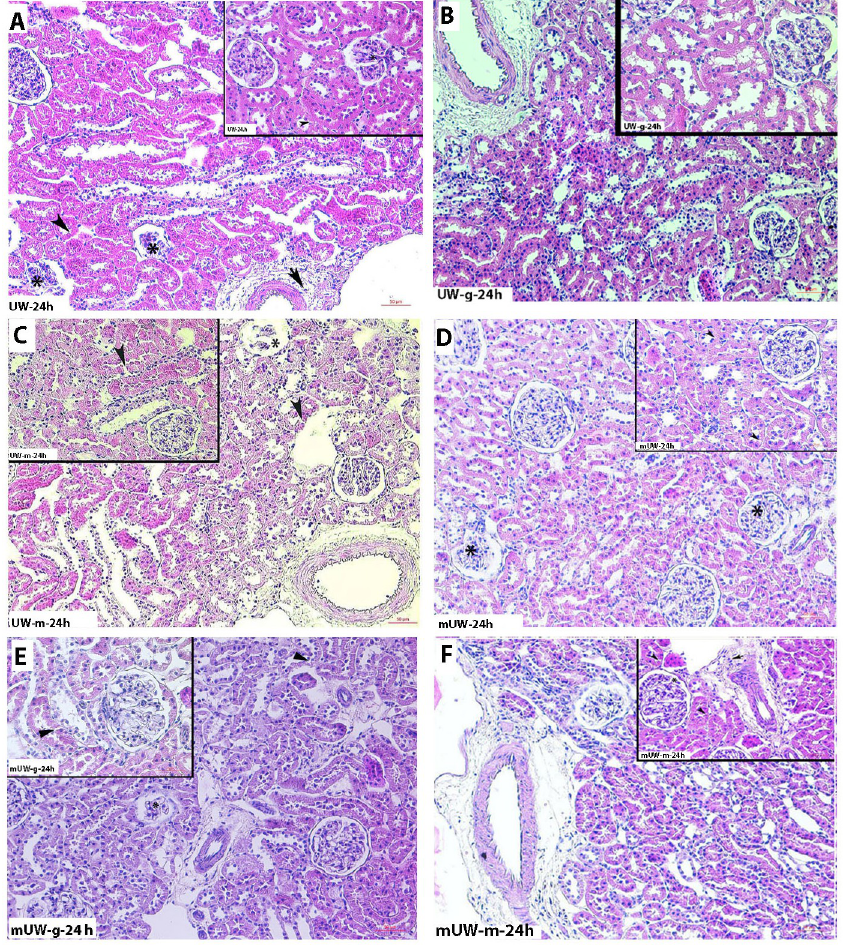
Fig 3. Photomicrographs of kidney tissues stored for 24 hours in experimental kidney preservation solutions. Glomerular degeneration (asterisk), tubular degeneration (arrowhead), inflammatory cell infiltration (short arrow) in UW (A) group. Mild degree of tubular degeneration (arrowhead) in UW-g (B) and UW-m (C) groups. Low degree of glomerular (asterisk) and tubular degeneration (arrowhead) in mUW (D) and mUW-g (E) groups. Low degree of glomerular degeneration (asterisk), tubular degeneration (arrowhead) and inflammatory cell infiltration (short arrow) in mUW-m Group (F) . H&E staining, A,B,C,D,E,F x200 magnification, insets: x400 magnification.